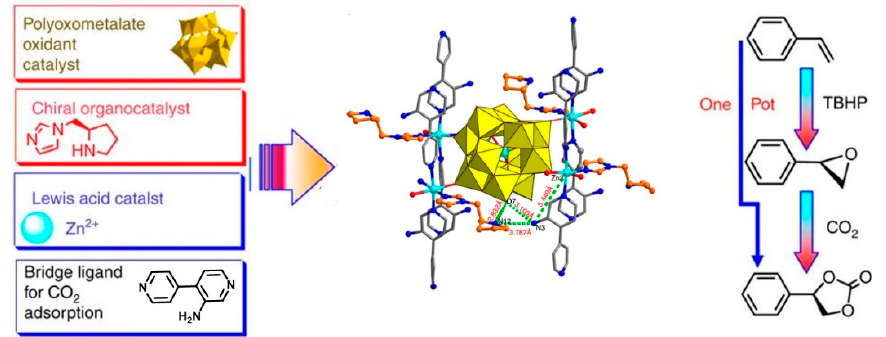
Figure 16. Synthetic procedure of the polyoxometallate-organocatalyst-metal organic frameworks (POMOFs) and the schematic representation of tandem catalysis for the asymmetric cyclic carbonate transformation from olefins and CO 2 . Color code: α -[ZnW 12 O 40 ] 6 − , yellow polyhedral; Zn, cyan ball; N, blue ball; C, orange ball; O, red ball; H atom was omitted. Reprinted with permission from [81]. Copyright © 2015 Attribution 4.0 International (CC BY